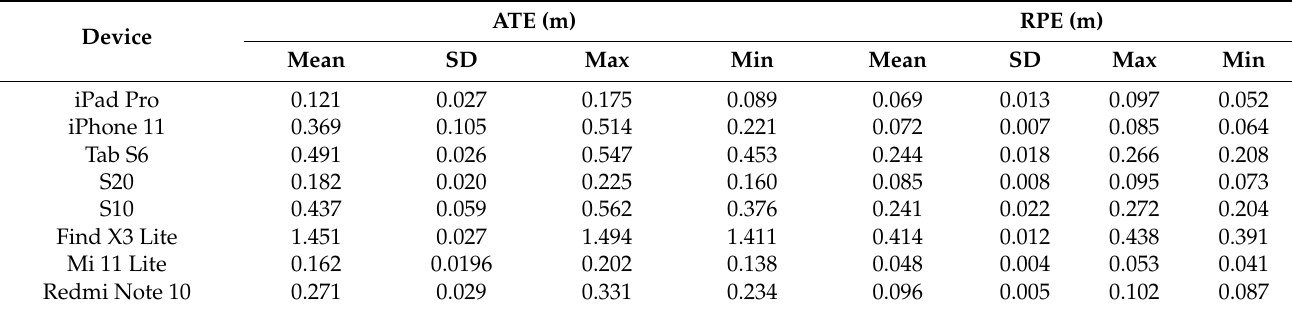
Table 4. Mean, standard deviation (SD), maximum (Max), and minimum (Min) of ATE and RPE values in the case of the eight-shaped path for all